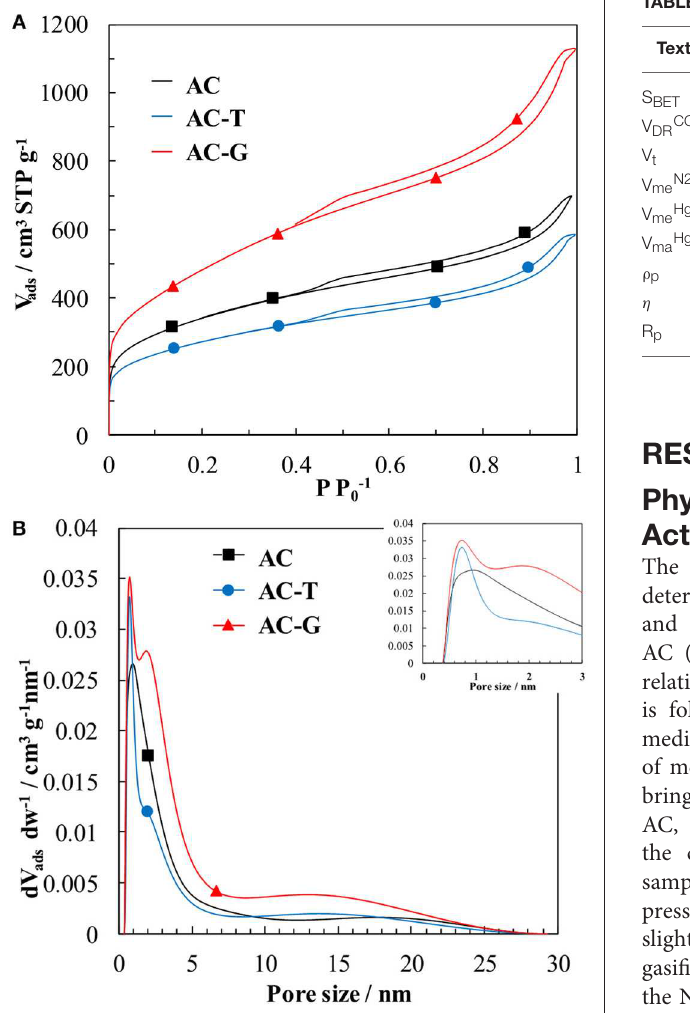
TABLE 1 | Textural properties of activated carbon